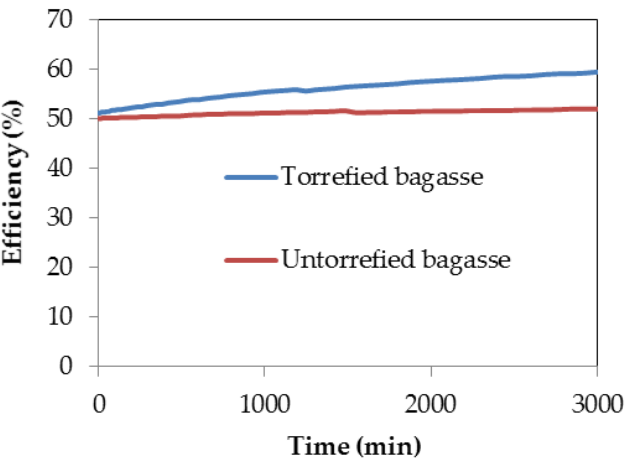
Figure 8. Conversion efficiency obtained after computer simulation of the gasification processes of torrefied and untorrefied SCB.